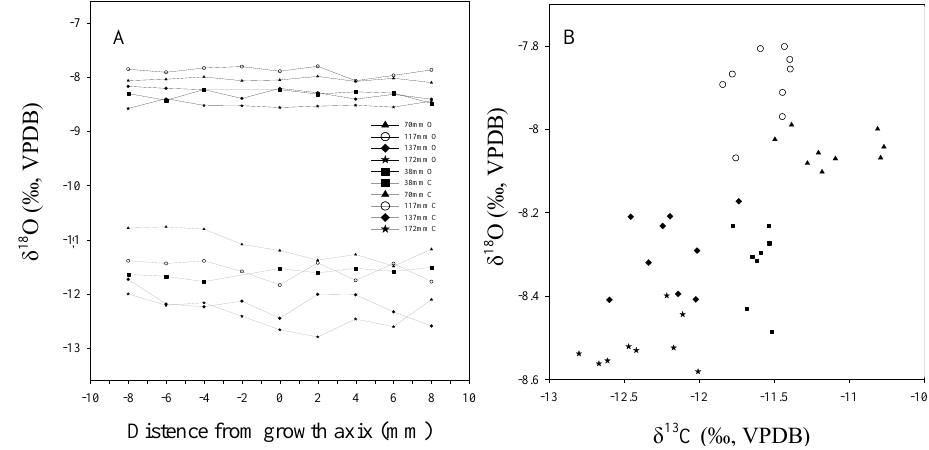
Fig. 4. The Hendy Tests for the stalagmite BD. (A) δ 18 O and δ 13 C profiles along five growth layers show no substantial isotopic fractionation. δ 18 O variations along the same layer are relative small ( < 0.3‰) compared with the variations along the growth axis. (B) δ 18 O versus δ 13 C for growth layers. Correlations between δ 18 O and δ 13 C are statistically insignificant.